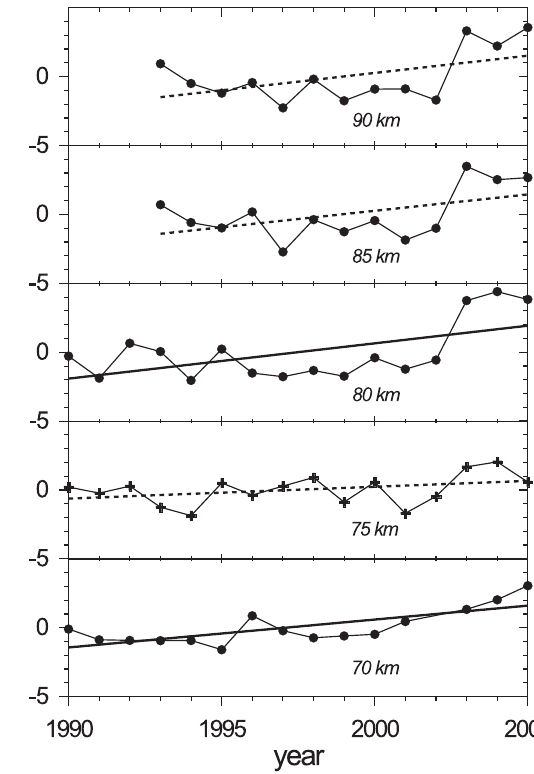
Fig. 19. Trend of the yearly averaged semidiurnal tidal amplitudes at Juliusruh after elimination of the solar activity induced parts for different heights. Significance levels are characterized by full lines and dots ( χ ≥ 95%) or dashed lines and dots ( χ ≥ 90%), non- significant levels by dashed lines and crosses ( χ<